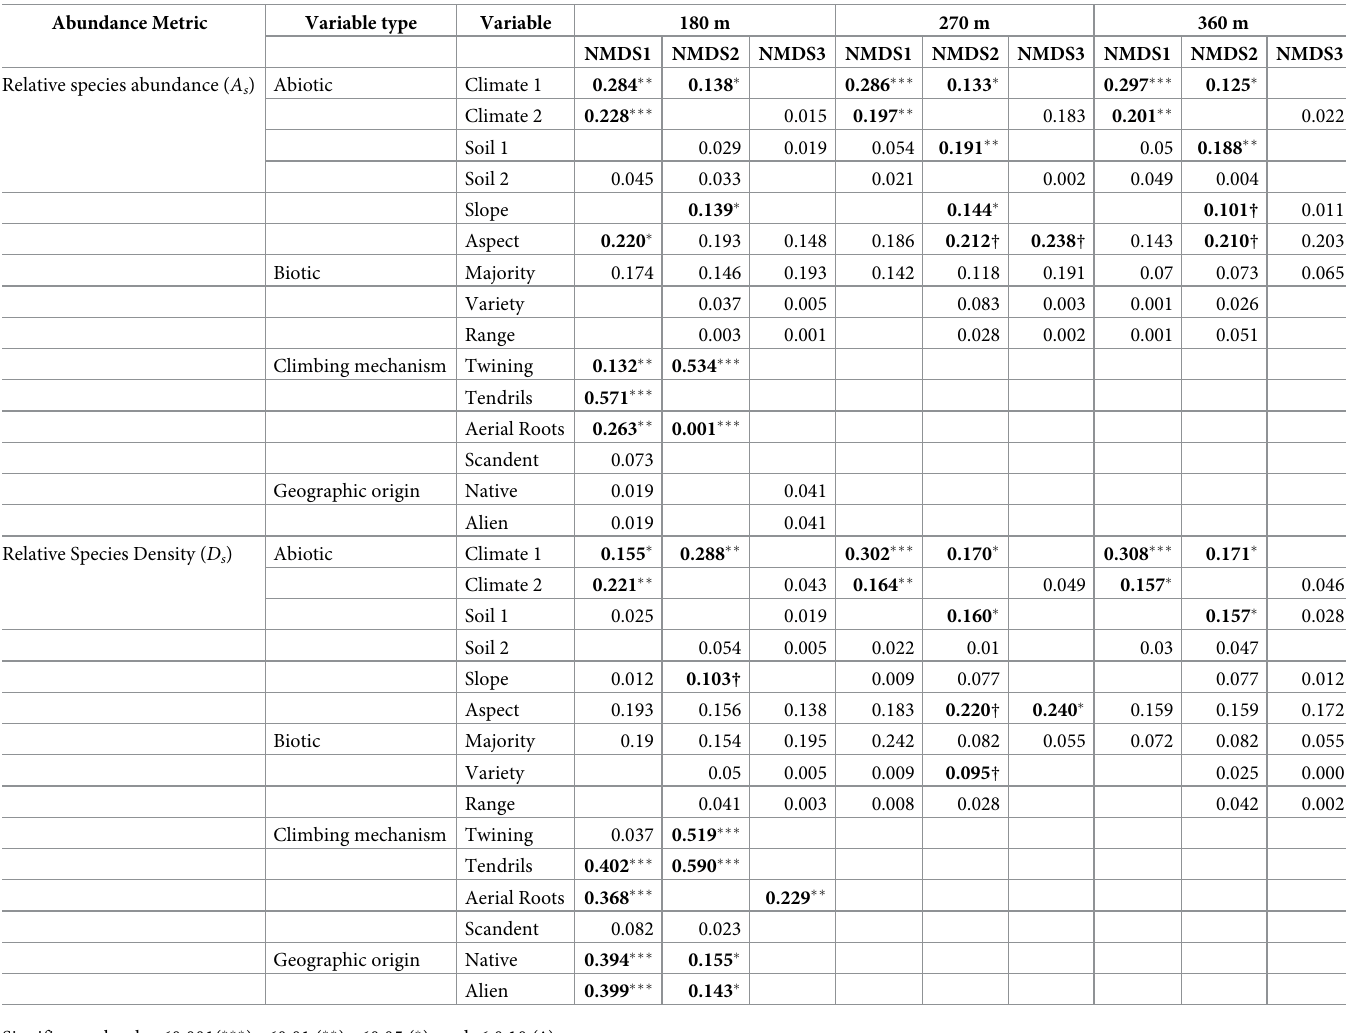
Table 3. Results of NMDS ordinations. R-squared values for the correlations between abiotic and biotic variables, including functional traits and geographic origin, with the three first axes of the ordinations using permutations tests (n = 1000). Abundance